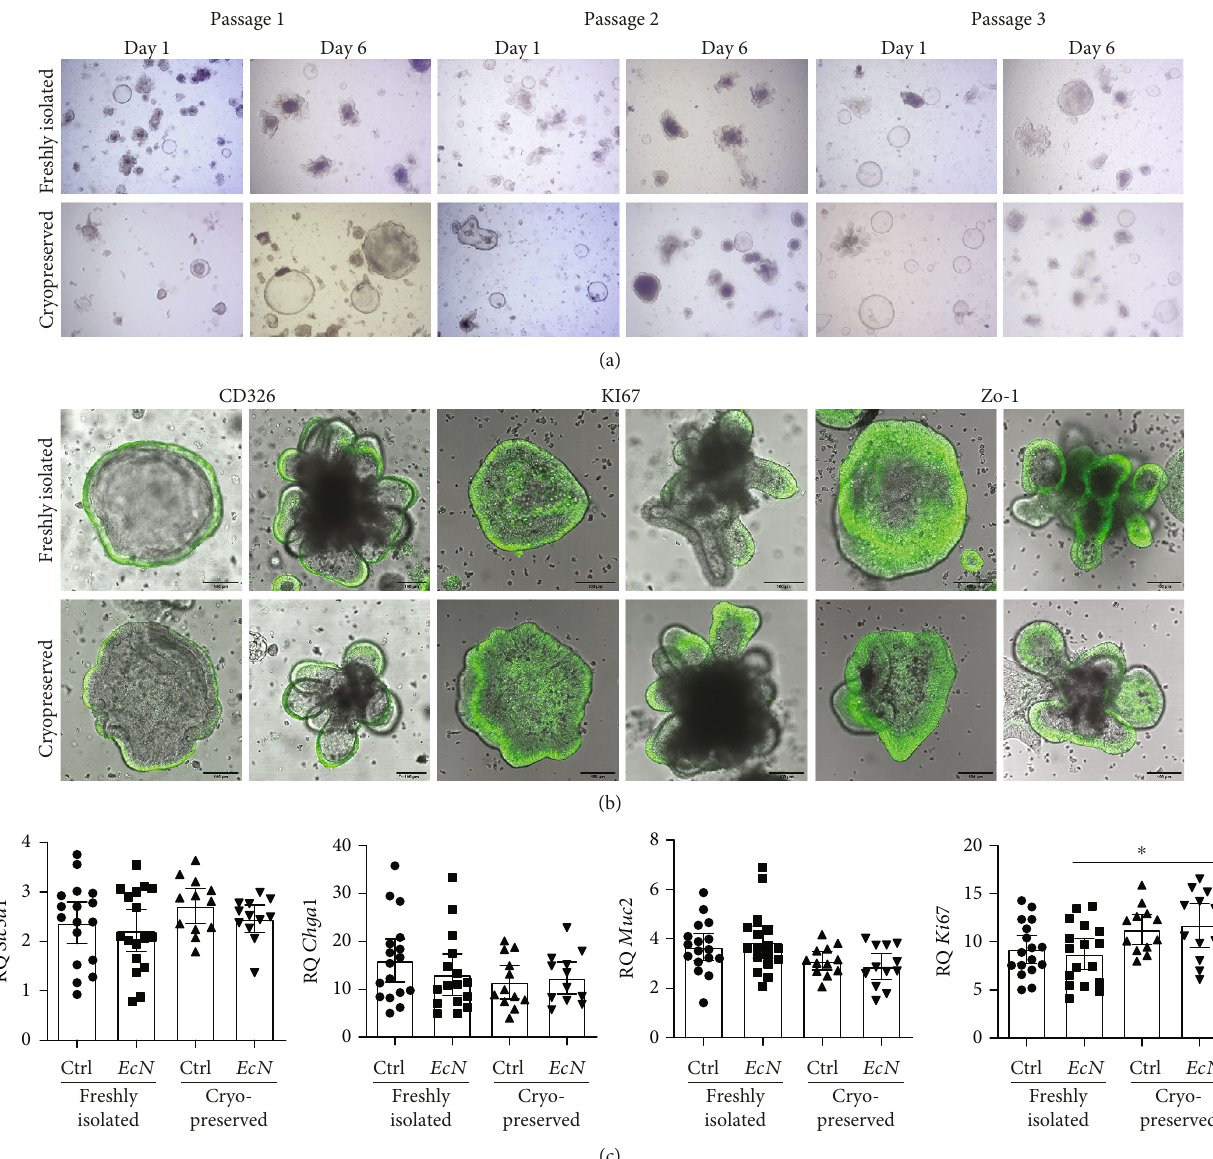
Figure 3: Characterization of freshly isolated and cryopreserved colonoids during growth and after Ec N infection. (a) Representative light phase-contrast images. (b) Immuno fl uorescent staining for epithelial cell adhesion molecule (CD326), KI67, and tight junction protein 1 (ZO-1). (c) The gene expression levels in freshly isolated colonoids ( n = 17 ) and cryopreserved and thawed organoids ( n = 12 ) of the same passage were compared before and after infection with Ec N. The graphs plot the pooled technical replicate means of biological replicates plus the overall mean and 95% CI. ∗ P < 0 : 05 , ∗∗ P < 0 : 01 , ∗∗∗ P < 0 : 001 , and ∗∗∗∗ P < 0 : 0001 . Relative Slc5a1